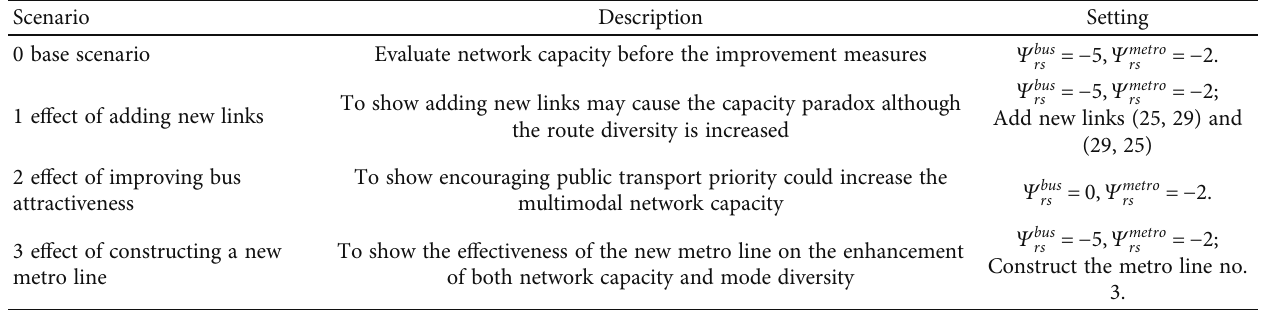
Table 2: Scenarios for evaluating network capacity.